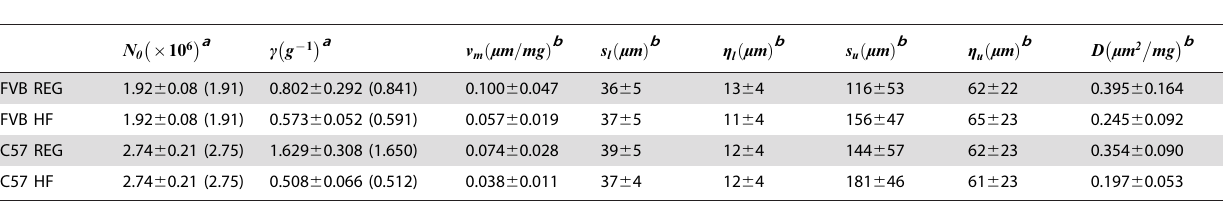
Table 2. Parameter values of adipose tissue growth